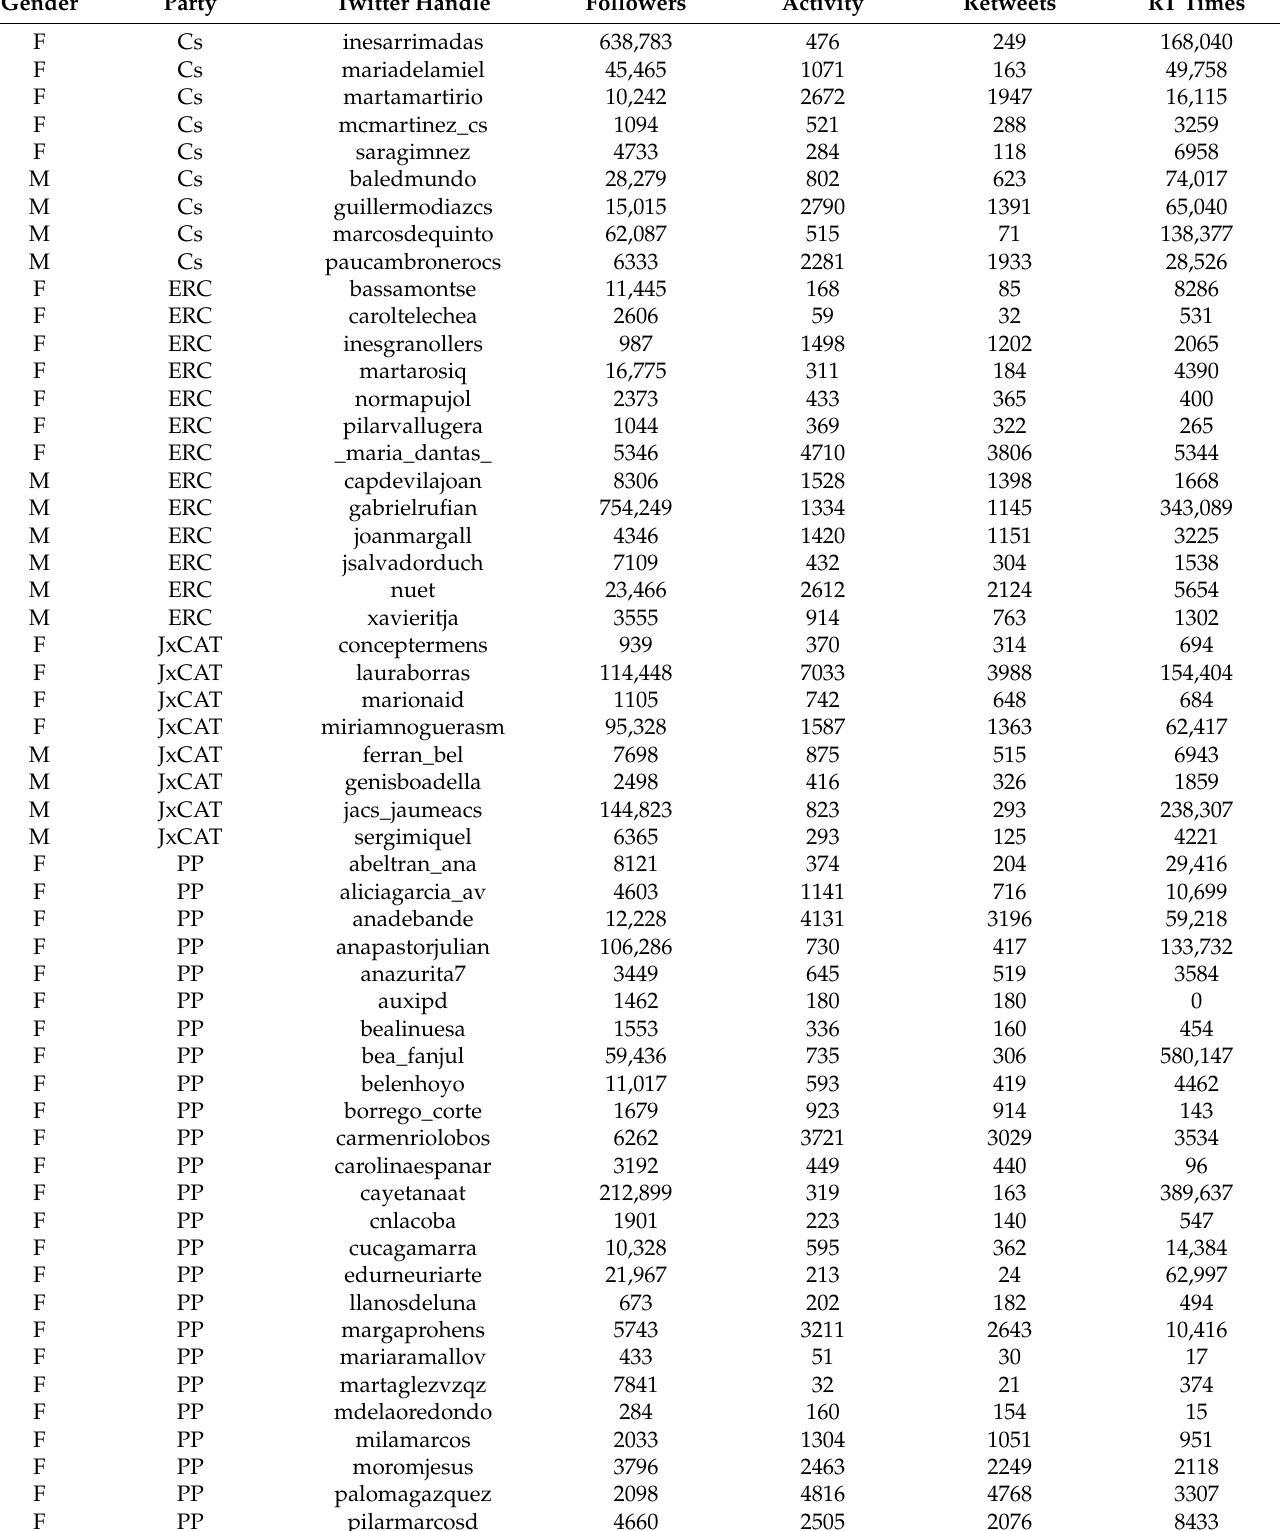
Table A1. Twitter data of the 277 Spanish Members in the